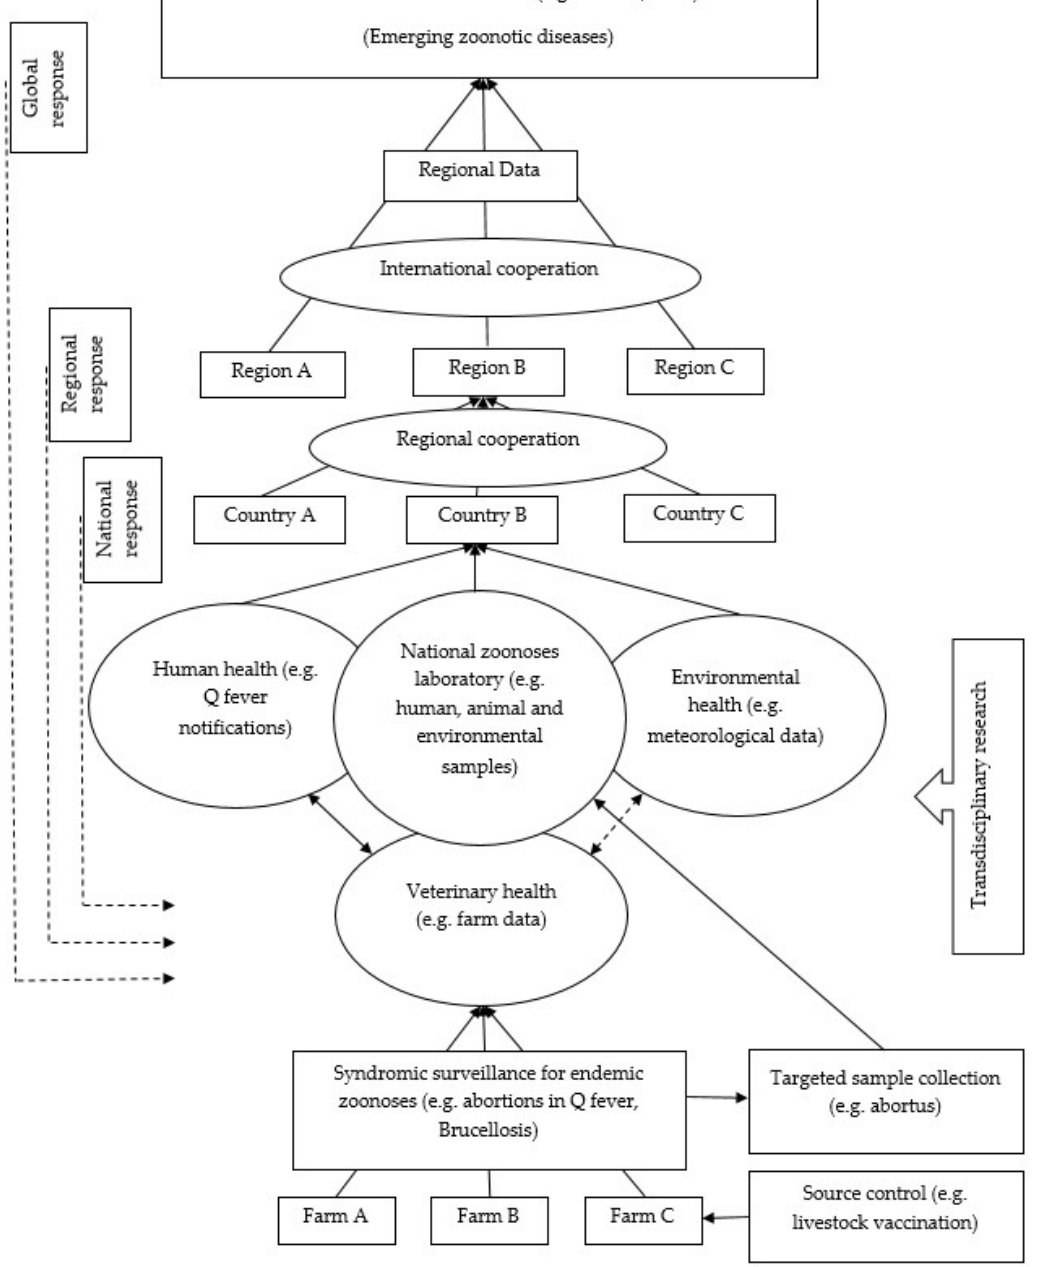
Figure 3. Schematic illustration of a One Health global zoonoses surveillance system. Conceptualized from [19,26,27,32]. * GHSA: Global Health Security Agenda; ¢ IHR: International Health Regulations.